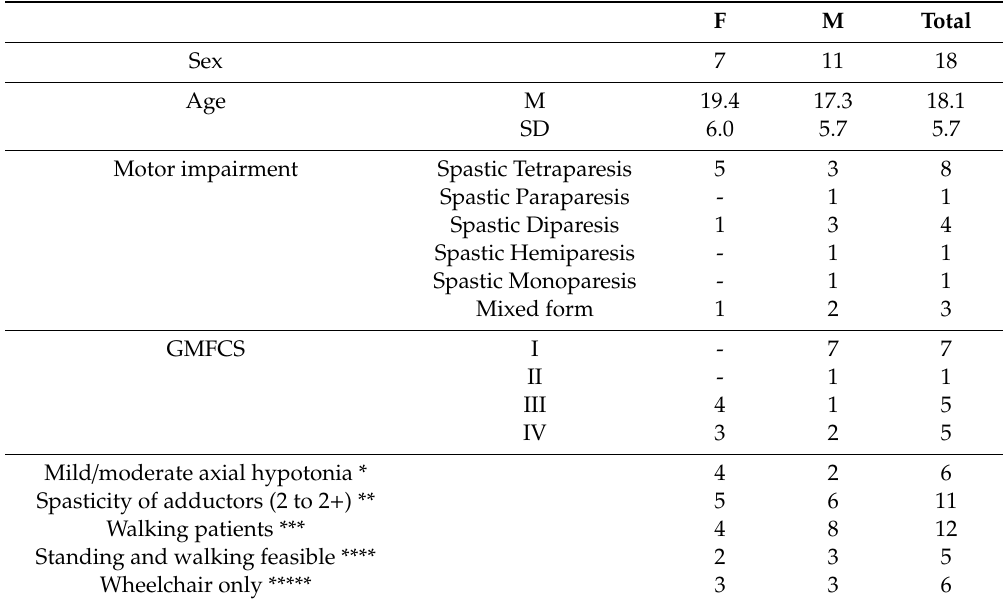
Table 1. General characteristics of the